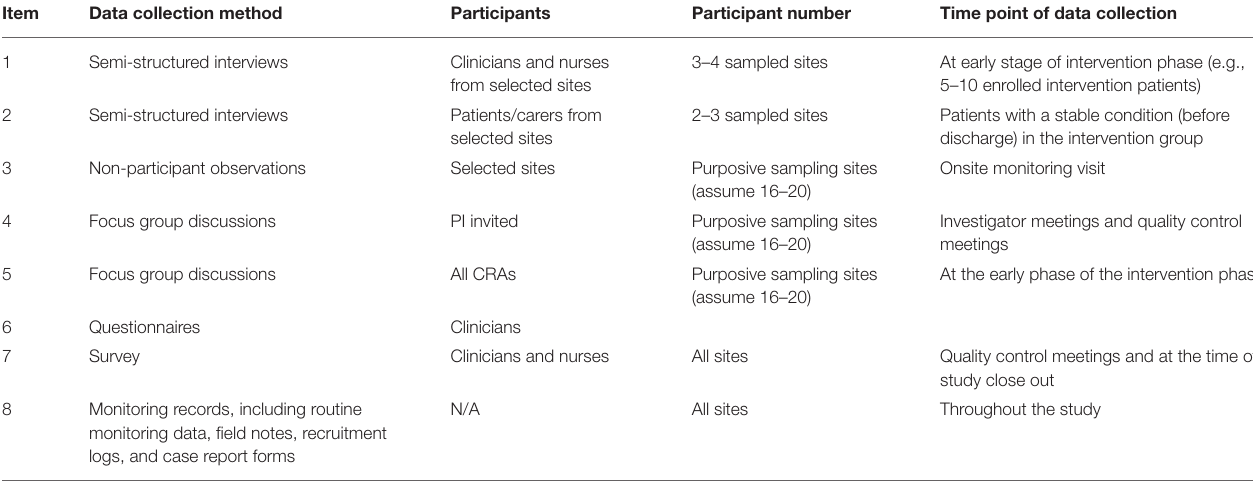
TABLE 1 | Summary of data collection methods.